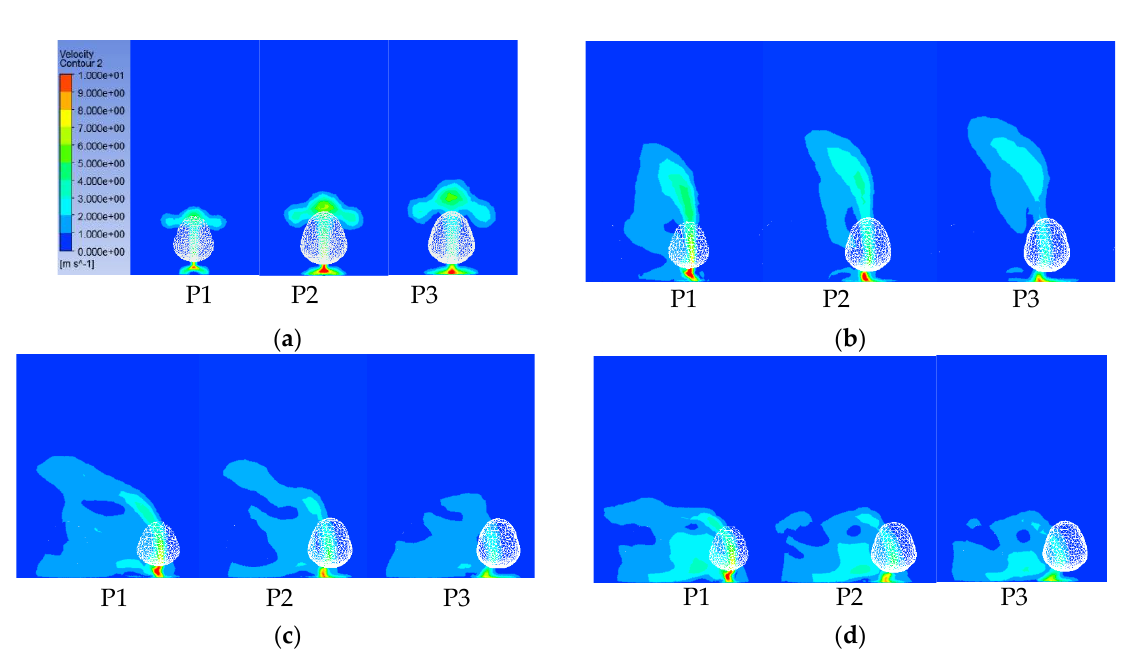
Figure 5. Distribution of airflow in the canopy at different traveling speeds. ( a ) v = 0 m/s, ( b ) v = 0.5 m/s, ( c ) v = 1 m/s, ( d ) v = 1.5 m/s.